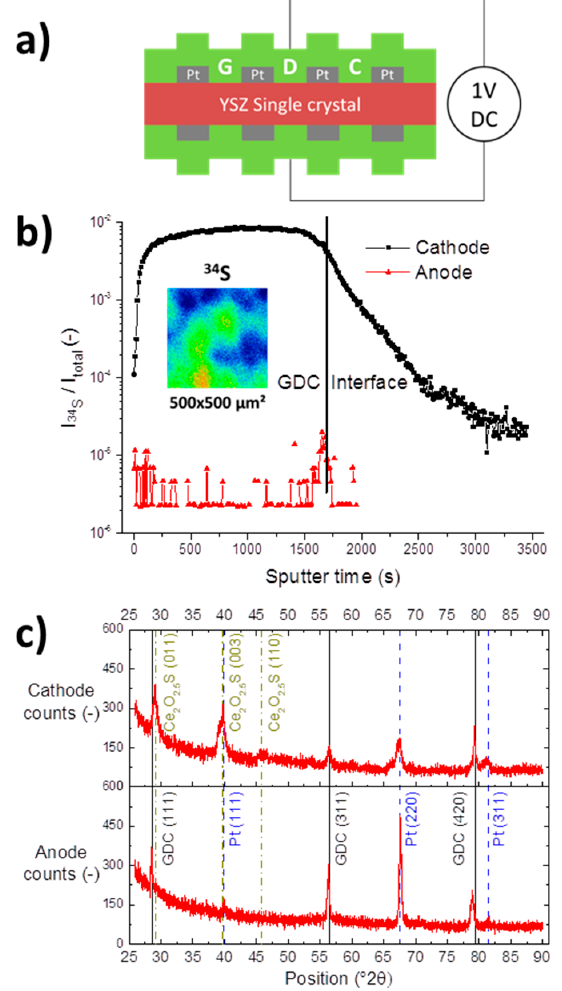
Figure 6. ( a ) Schematic cross sectional view and wiring of the electric sulphur implantation experiment. Both sides of a YSZ single crystal were covered with a model composite Pt/GDC 20 electrode layer and polarised for 48 h at 1 V at 750 °C in 2.5% vol H 2 in Ar with a hydrogen to water ratio of 1:1; ( b ) ToF-SIMS depth profiles of the normalized 34 S signal of the anode and cathode